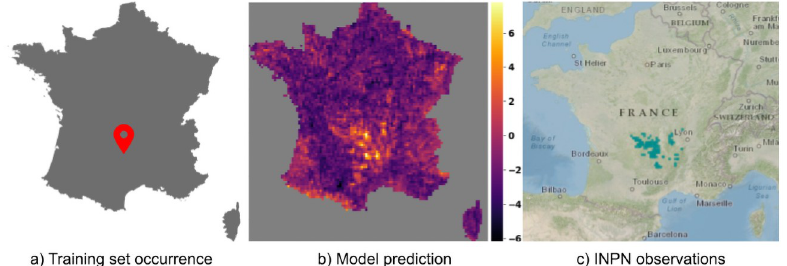
Fig 6. Prediction of Senecio cacaliaster Lam., 1779. Compare the model prediction to the French National Inventory of Natural Heritage (INPN) occurrences map for Senecio cacaliaster Lam., 1779.